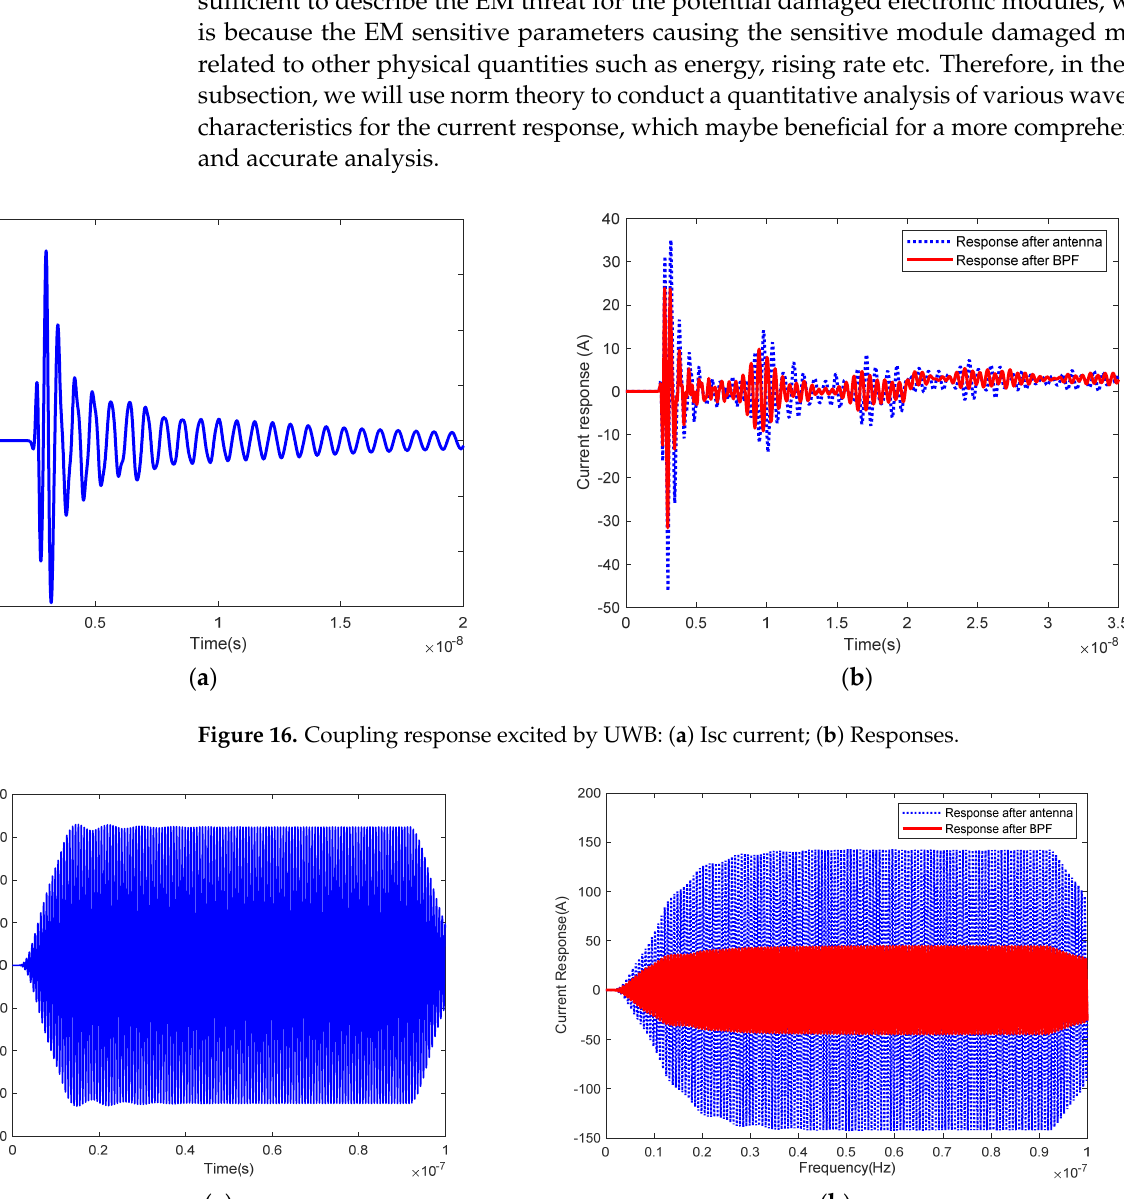
Figure 17. Coupling response excited by HPM: ( a ) SC current; ( b ) Responses.